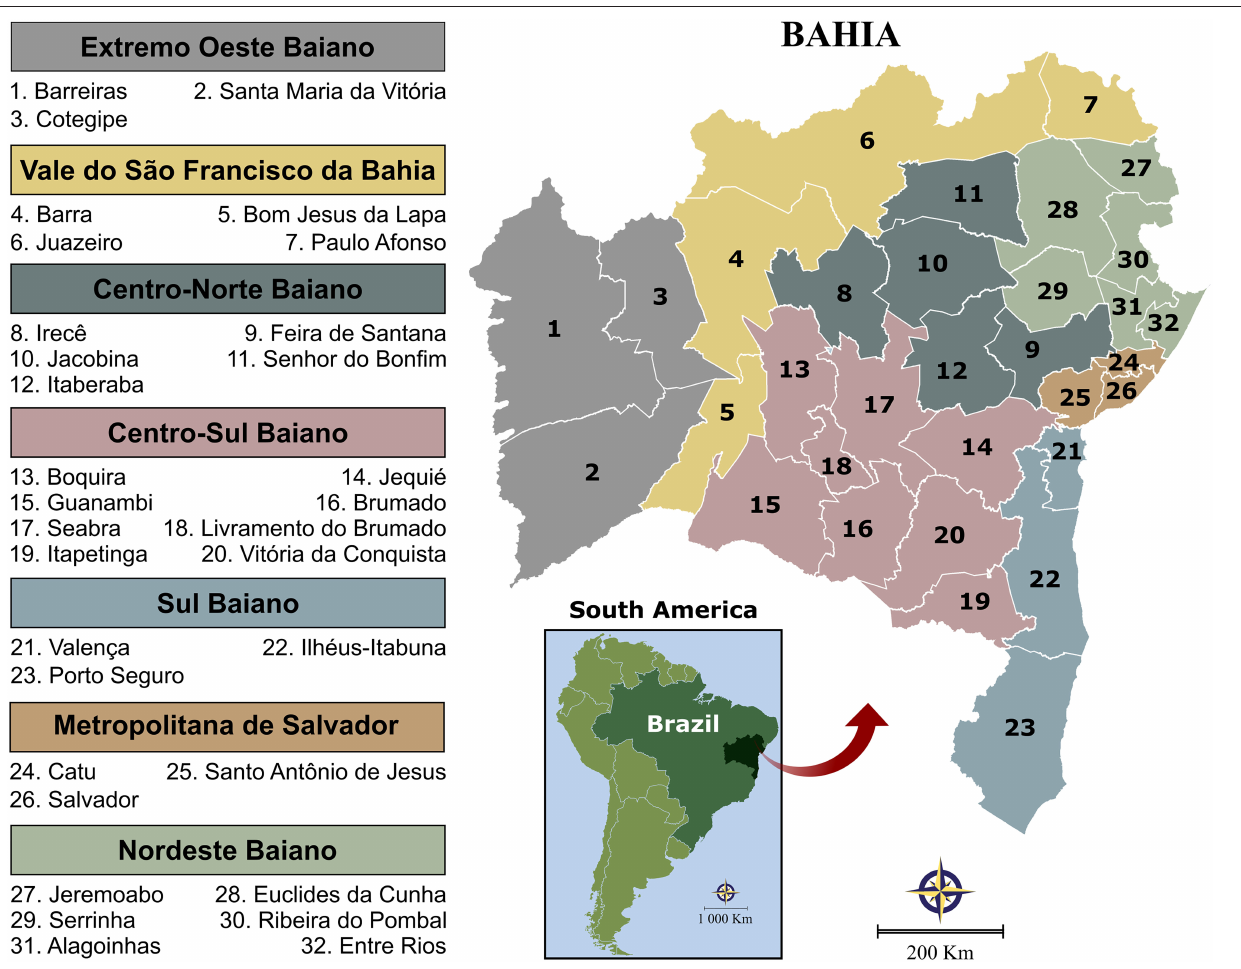
FIGURE 1 | Illustration of the state of Bahia’s seven mesoregions and 32 microregions, as determined by IBGE to more accurately reflect economic and social similarities among the 417 municipalities. Digital maps in the public domain were obtained from the IBGE cartographic database in shapefile format (.shp), which was subsequently reformatted and analyzed using QGIS version 3.10 (Geographic Information System, Open-Source Geospatial Foundation Project. http://qgis.osgeo.